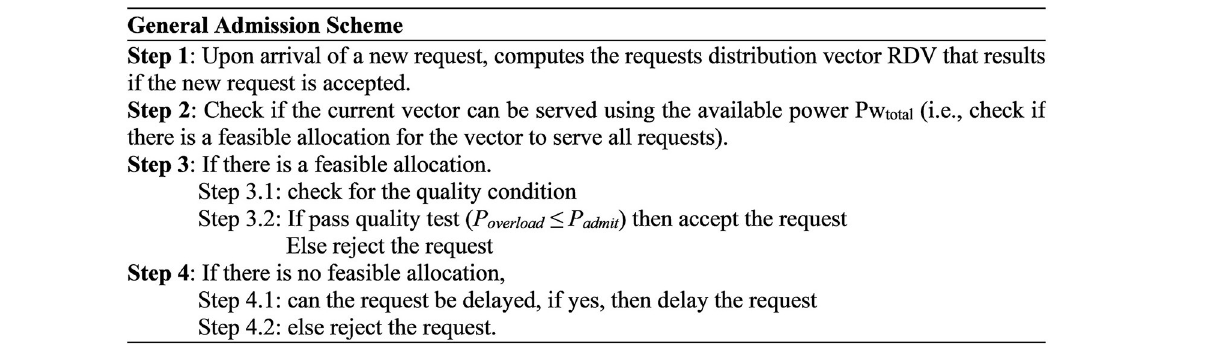
FIGURE 3 | General admission